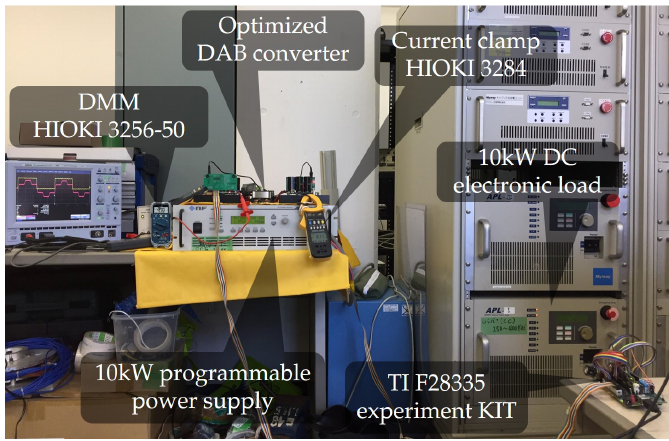
Figure 10. A 10 kW, three-phase DAB converter prototype.